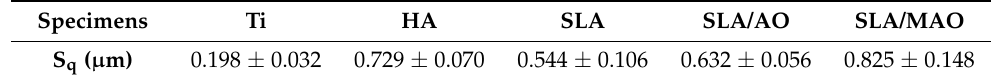
Figure 4. Roughness of surface-modified Ti: ( a ) Ti, ( b ) HA, ( c ) SLA, ( d ) SLA/AO, and ( e ) SLA/MAO. Table 1. S q value of surface-modified